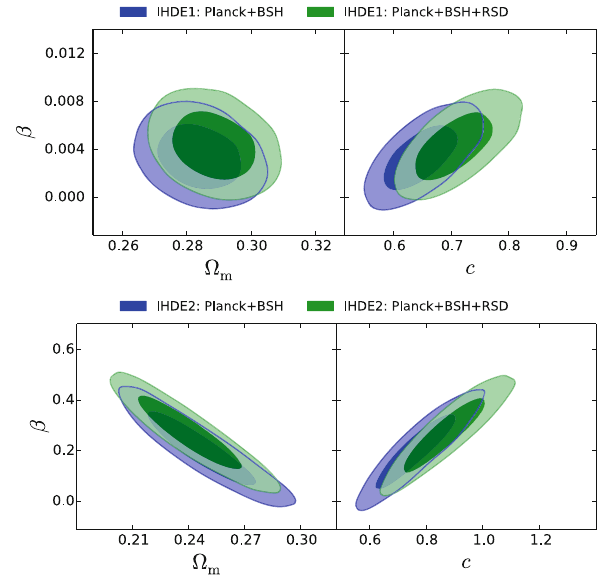
Fig. 3 Thetwo-dimensionalmarginalizedcontours (68.3% and95.4% confidence level) in the (cid:16) m – β and c – β planes for the IHDE1 ( Q = β H ρ